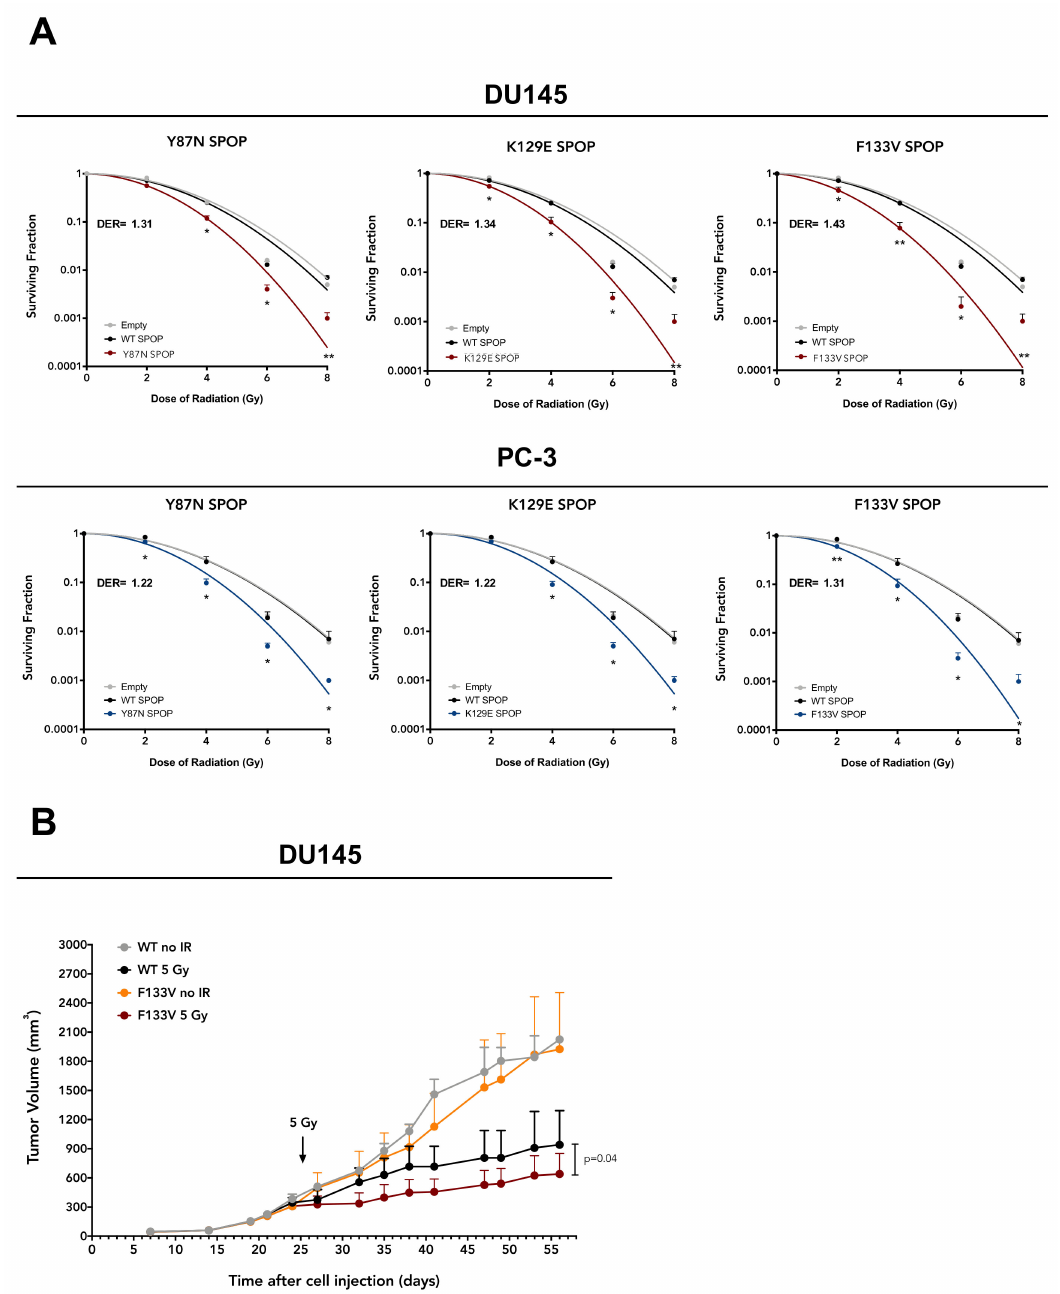
Figure 2. SPOP mutations sensitize PCa cell and animal models to ionizing radiation. ( A ) Clonogenic cell survival curves of DU145 and PC-3 cells ectopically expressing WT or mutant (Y87N, K129E, F133V) SPOP and exposed to increasing doses of irradiation (2, 4, 6 and 8 Gy). The surviving fraction is reported as mean ± SD values from three independent experiments. The level of significance was represented as * p < 0.05, ** p < 0.01, Student’s t -test. The dose enhancement ratio (DER) was calculated as the dose (Gy) for the radiation plus mutant SPOP divided by the dose (Gy) for radiation plus WT SPOP at a surviving fraction of 0.1. ( B ) DU145 cells stably expressing WT or F133V SPOP (1 × 10 7 ) were subcutaneously implanted into SCID mice. When tumors reached ~300 mm 3 , mice were randomly assigned to four groups (8 mice / group) and treated with 5 Gy single dose irradiation locally delivered to the tumor. Tumor growth volume (mm 3 ) was measured with a Vernier caliper on indicated days after cell